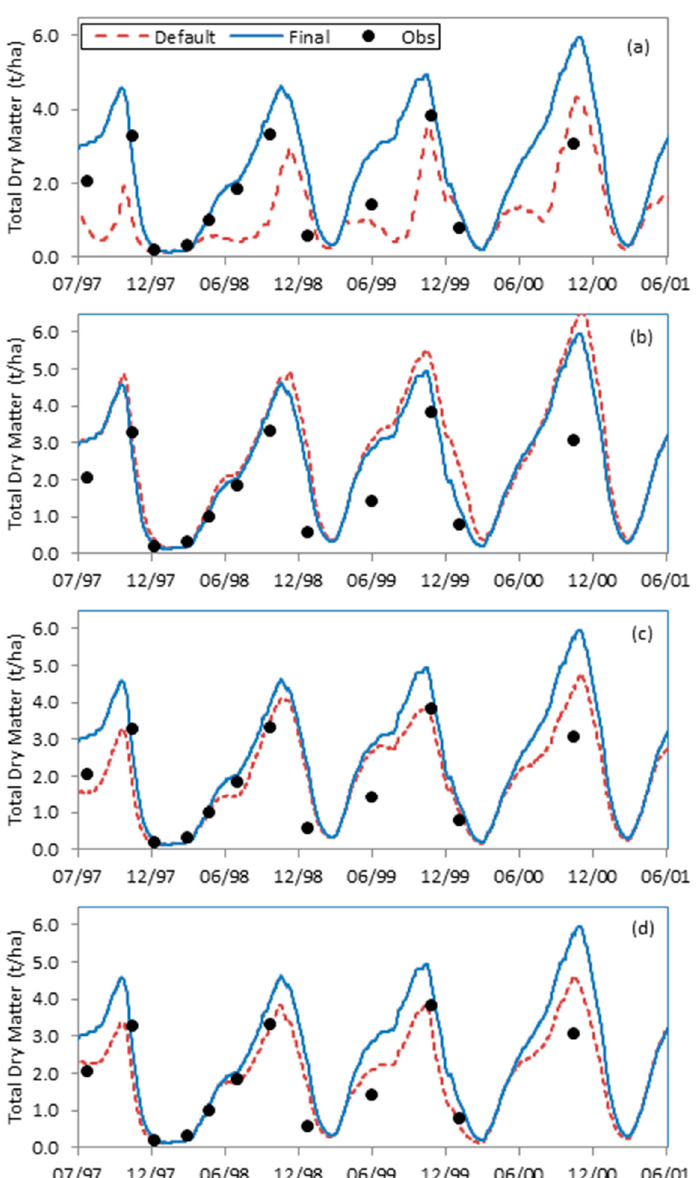
Figure 2. Comparison of sward pasture dry matter production in the MM system with modification of ( a ) temperature extreme stresses for low (implemented) and high (not implemented) ( b ) rooting depth of Phalaris ( c ) minimum temperature for leaf mass flux, and ( d ) N 2 fixation. The “final” parameter value set was used in the simulations and the default was the final set with only the selected parameter modified.